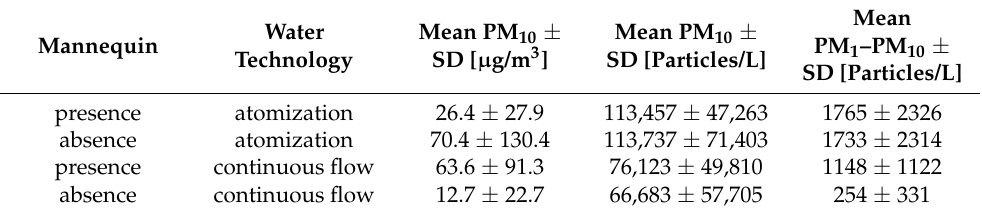
Table 3. Mass and number of inhalable particles emitted during a showering event in the presence or absence of a mannequin.